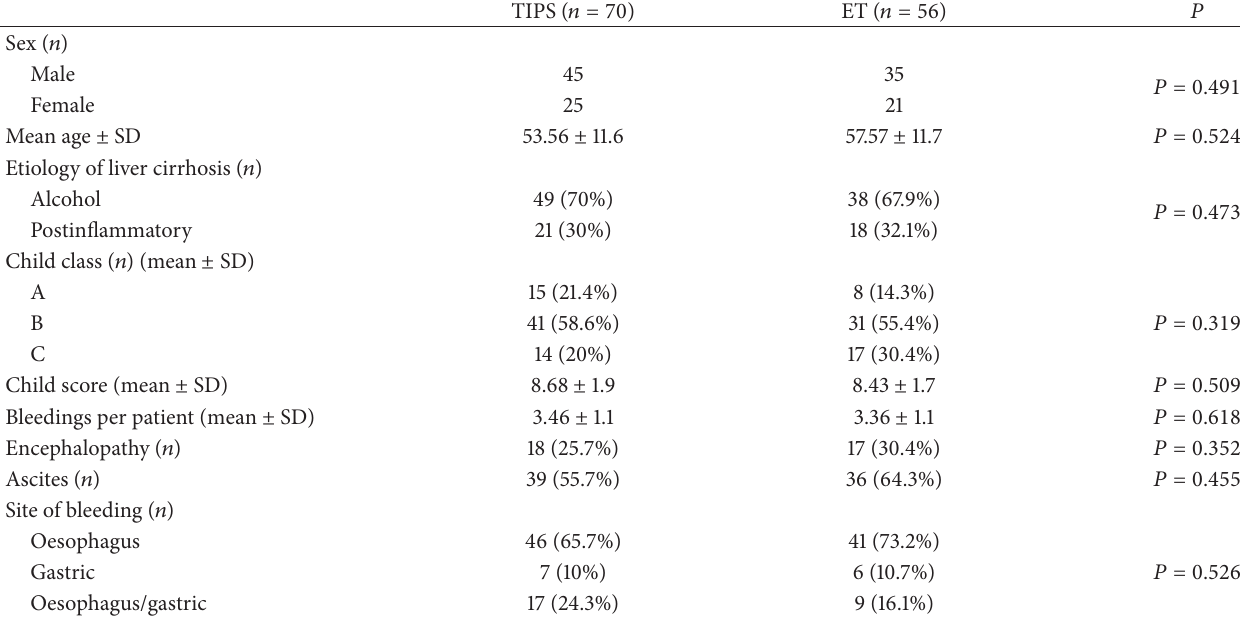
Table 1: Demographic and clinical characteristics of the